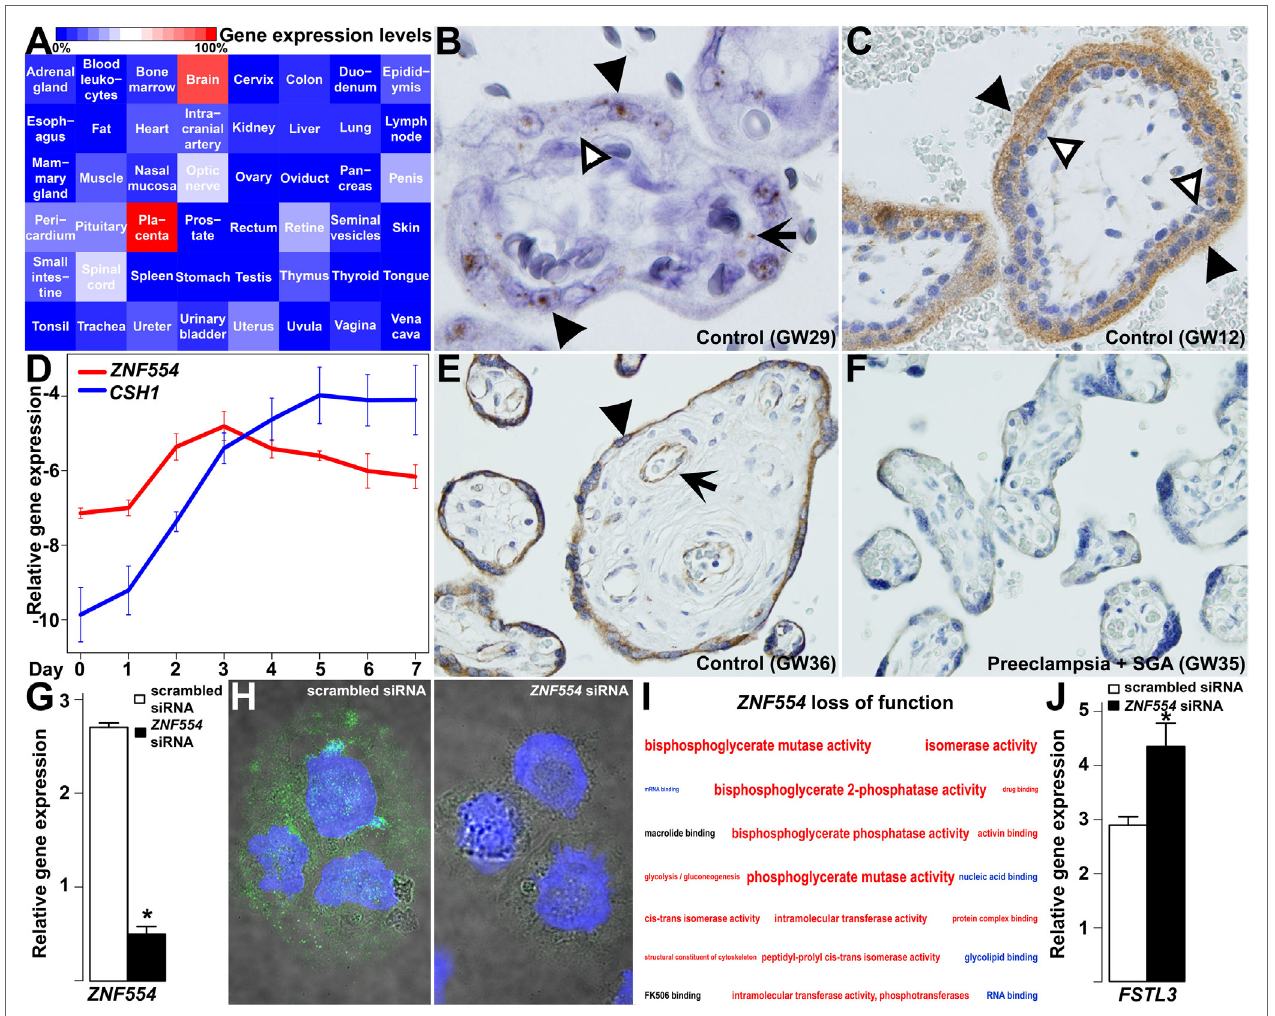
FigUre 9 | ZNF554 down-regulation in the villous trophoblast (VT) in preeclampsia. (a) Tissue qRT-PCR array revealed the highest ZNF554 expression in the placenta among 48 human tissues. Color code depicts gene expression levels relative to that of the placenta (100%). (B) In situ hybridization of a third trimester control placenta (GW29) and (c) immunohistochemistry of a first trimester placenta (GW12) shows mainly syncytiotrophoblastic ZNF554 expression (hematoxylin counterstaining, 1,400 and 400 × magnifications, respectively). Black or white arrowheads depict syncytiotrophoblast or cytotrophoblast, while black arrow depicts fetal endothelium, respectively. (D) qRT-PCR revealed that ZNF554 expression is up-regulated during VT differentiation in parallel with CSH1 . (e,F) ZNF554 immunopositivity was faint in the syncytiotrophoblast in preeclampsia [ (F) , GW35] compared to gestational-age matched controls [ (e) , GW36] (hematoxylin counterstaining, 400 × magnifications). Arrow and arrowhead depict syncytiotrophoblast and villous endothelium, respectively. (g) ZNF554 mRNA expression was 74% lower in ZNF554 -silenced BeWo cells compared to controls used for the microarrays ( p = 5.24 × 10 − 6 ). (h) Nuclear and cytoplasmic ZNF554 immunofluorescence decreased in BeWo cells treated with ZNF554 siRNA compared to control cells (3,500 × magnifications). (i) Molecular functions and one Kyoto Encyclopedia of Genes and Genomes (KEGG) pathway (glycolysis/gluconeogenesis) affected in ZNF554 -silenced BeWo cells. Colors denote the proportions of up- or down-regulated genes (red: > 0.5 up-regulated; blue: > 0.5 down-regulated; black: 0.5–0.5 up- and down-regulated). Letter sizes represent the minus log 10 of p -values of the given functions or pathway. (J) qRT-PCR validated FSTL3 up-regulation (2.7-fold, p < 0.001) in BeWo cells upon ZNF554